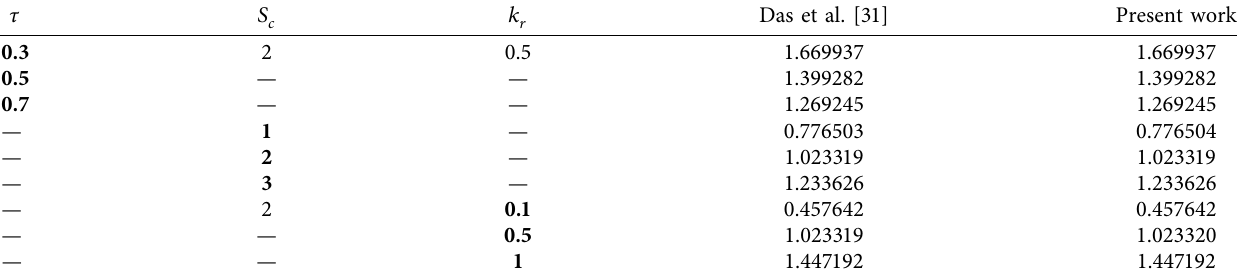
Table 4: Comparison of the Sherwood number S h calculated in the present work with the published work of Das et al. [31]. τ S c k r Das et al. [31] Present